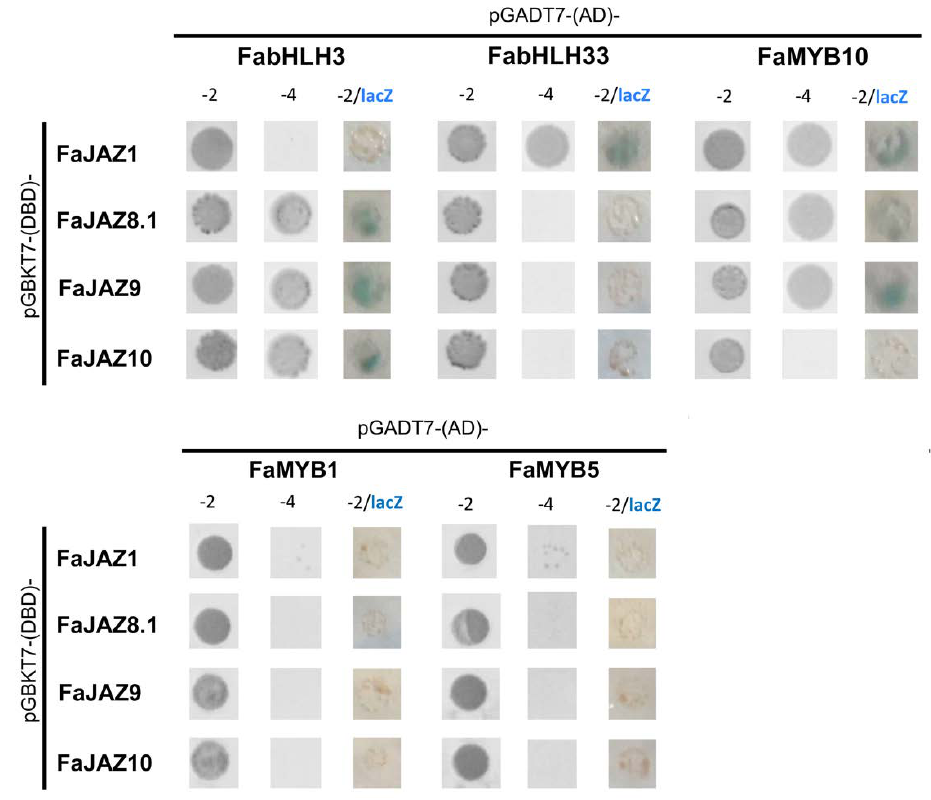
Figure 2. Protein–protein interactions of Fragaria × ananassa JASMONATE-ZIM DOMAIN (FaJAZs) repressors with anthocyanin-related transcription factors. FaJAZ1, FaJAZ8.1, FaJAZ9, and FaJAZ10 were cloned into pGBKT7-(DBD)-Gateway vector. F. × ananassa basic helix-loop-helix 3 (FabHLH3), FabHLH33, FaMYB10, FaMYB1, and FaMYB5 were cloned into the pGADT7-(AD)-Gateway vector. -